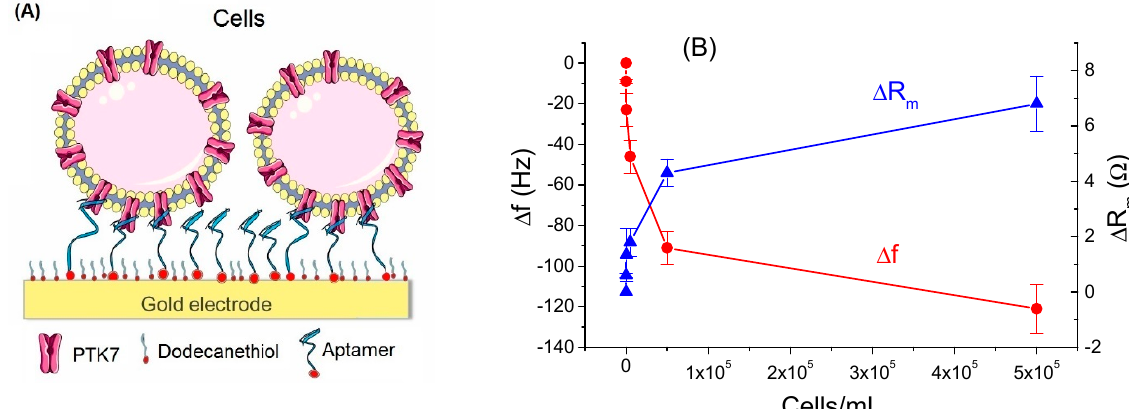
Figure 9. ( A ) The scheme of the sensing surface. Thiolated sgc8c aptamers are chemisorbed at the gold surface. 1-dode- canethiol formed hydrophobic patches at uncovered parts of the gold surface. ( B ) Plot of the changes of the resonant frequency, ∆ f, and motional resistance, ∆ R m , vs. concentration of MOLT-4 leukemic cells. Partially adopted with permission from [121] 2018 Wiley.